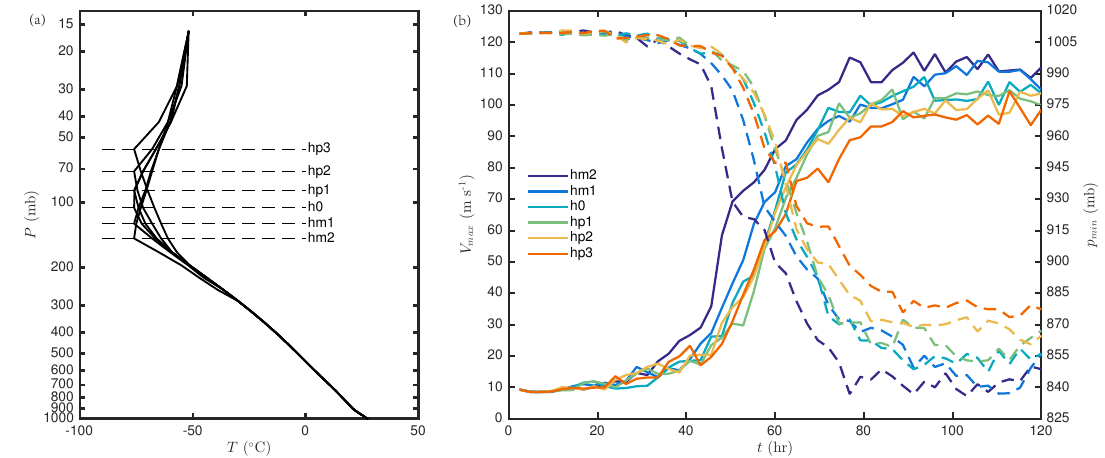
Figure 13. ( a ) A range of initial soundings (solid lines) used in the tropopause height experiments with the RE model, and ( b ) the time series of V max as a function of simulation time during the first 5 days into integration. hm2 (hp2) denotes the experiment with the lowest (highest) tropopause